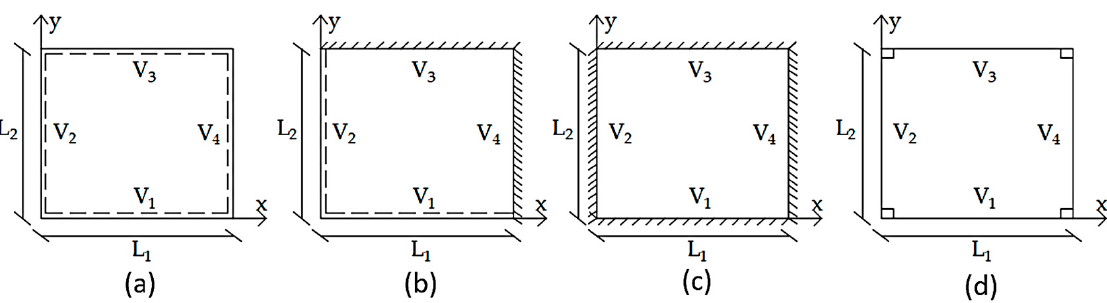
Figure 17. Scheme for ( a ) simply supported slab; ( b ) fixed-ended supported slab; ( c ) fixed-ended slab and ( d ) flat slab.